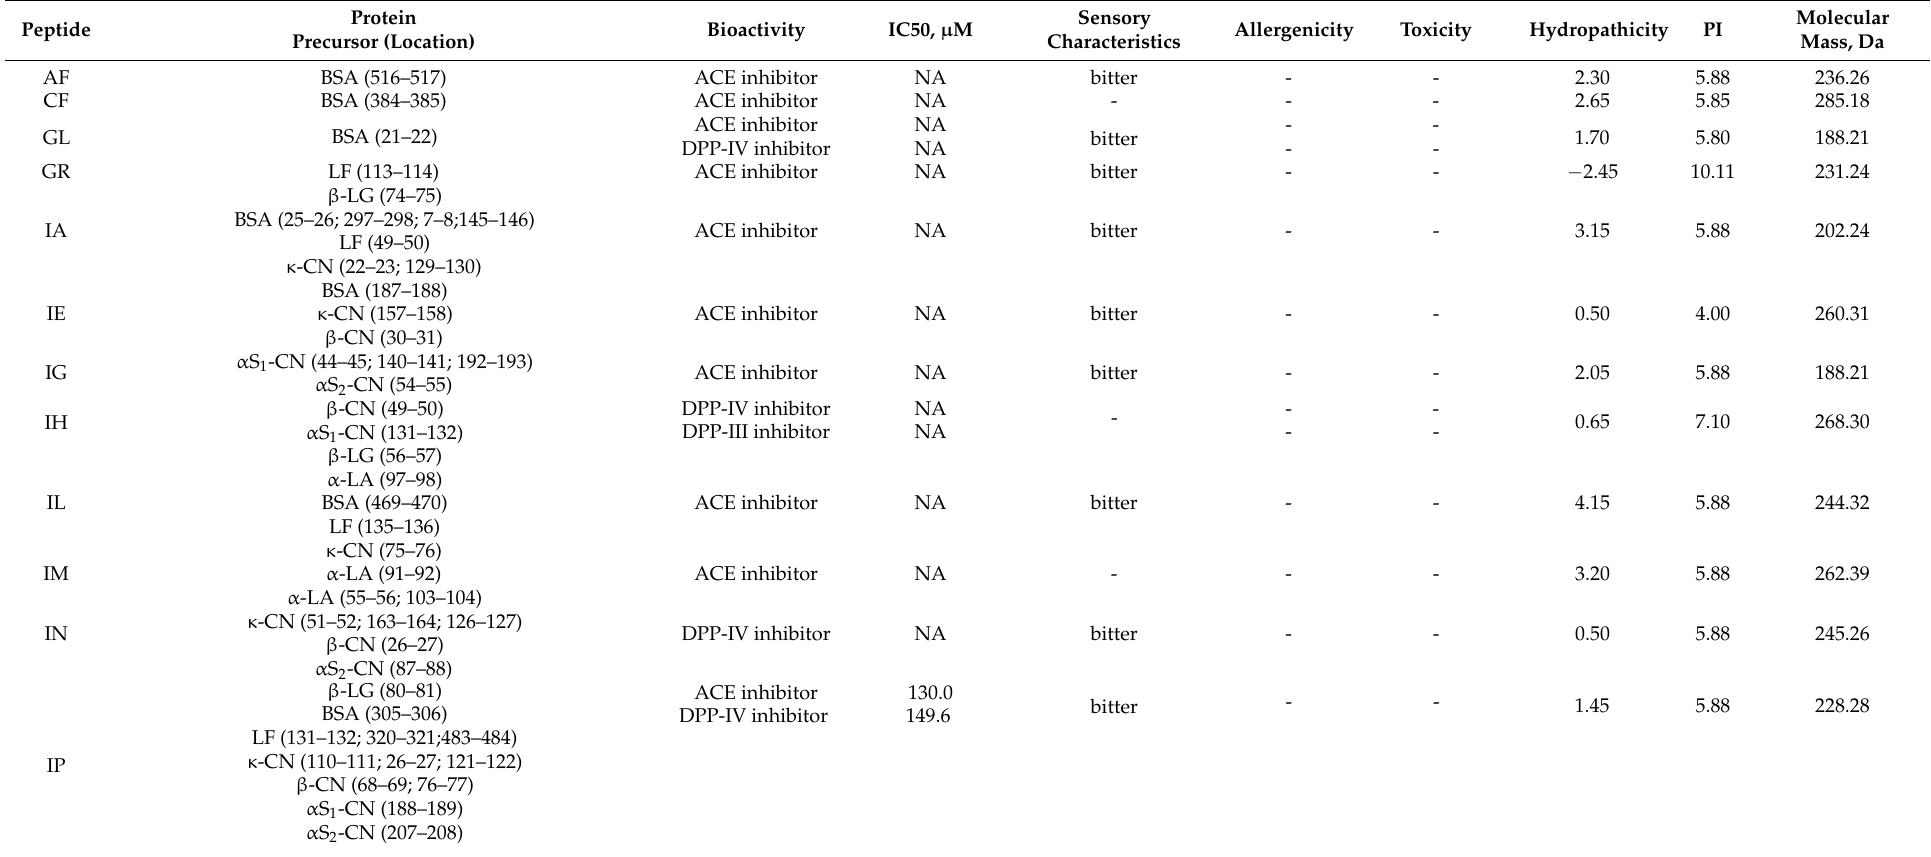
Table 7. Peptide mapping of the results of bioinformatic modeling of digestion in the gastrointestinal